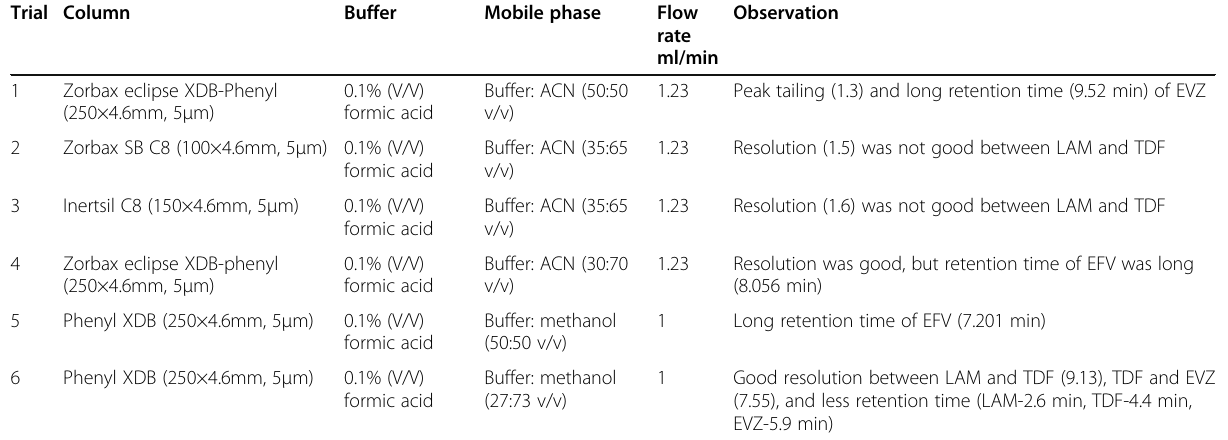
Table 1 Different trials Trial Column